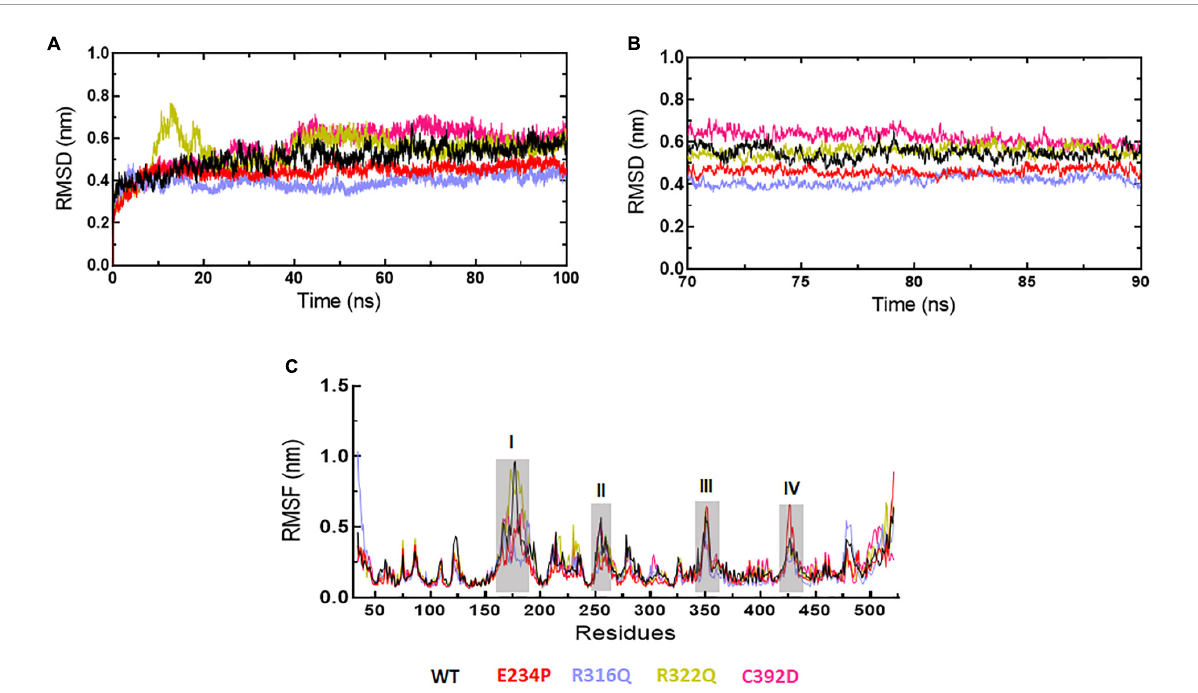
FIGURE2 MD simulation profiles of WT and MT proteins. (A) Root mean square deviation (RMSD) profiles of WT and different MTs measured in nanometers at function of time, (B) RMSD profiles of WT and different MTs from equilibrated trajectories of 70–90 ns time periods (20 ns total) measured in nanometers at function of time, and (C) Root mean square fluctuations (RMSF) of different MTs along with WT measured in nanometers. Highly fluctuated protein residues were shown in shaded areas and labeled in numbers. WT, E234P, R316Q, R322Q, and C392D were labeled in black, red, blue, mustard, and magenta color, respectively.